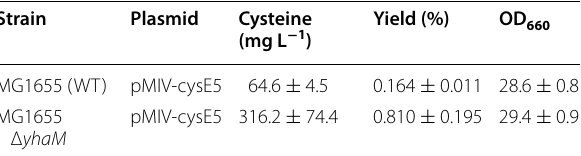
Table 4 Effects of yhaM deletion on the production of cysteine